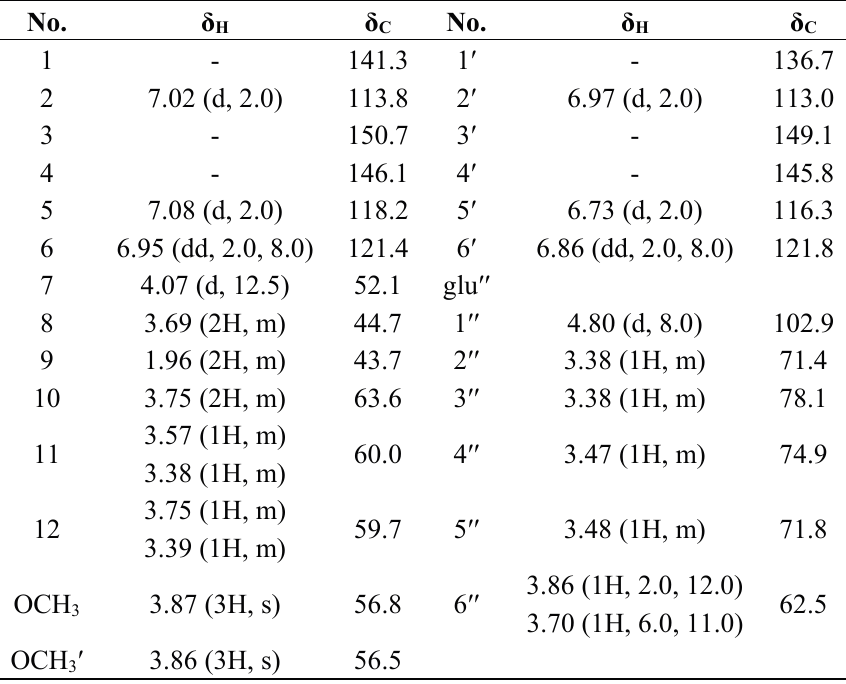
Table 3. 1 H- and 13 C-NMR data for 4 (500 and 125 MHz, δ ppm).